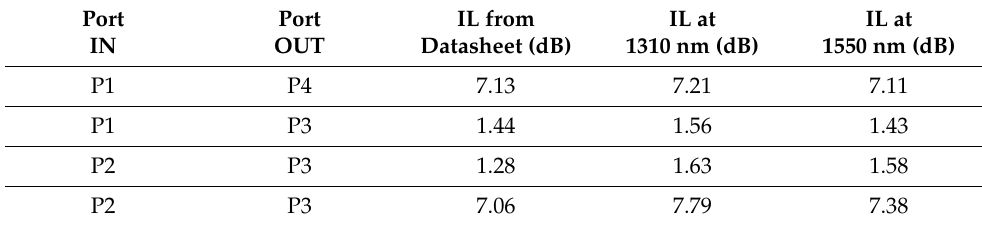
Table 1. Insertion loss of the coupler 80:20.